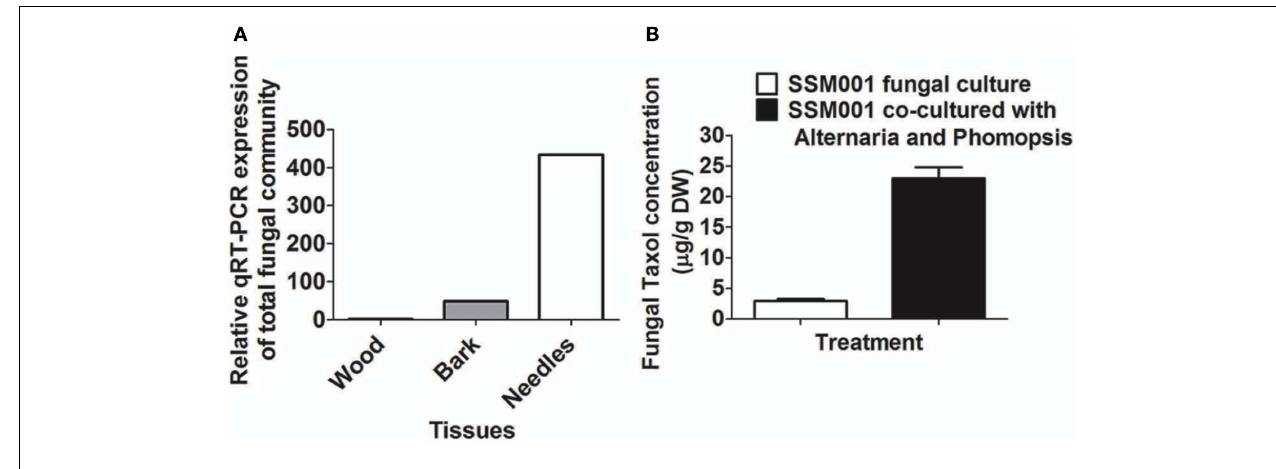
wood. (B) Effect of co-culturing of Alternaria and Phomopsis fungi isolated from outer bark and needles, respectively on SSM001Taxol production in liquid